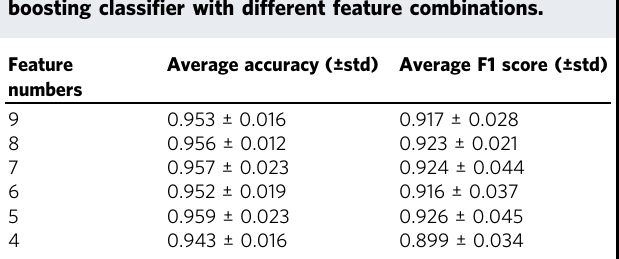
Table 3 A summary of average accuracy, average F1 score, and corresponding standard deviations of the gradient boosting classi fi er with different feature combinations.